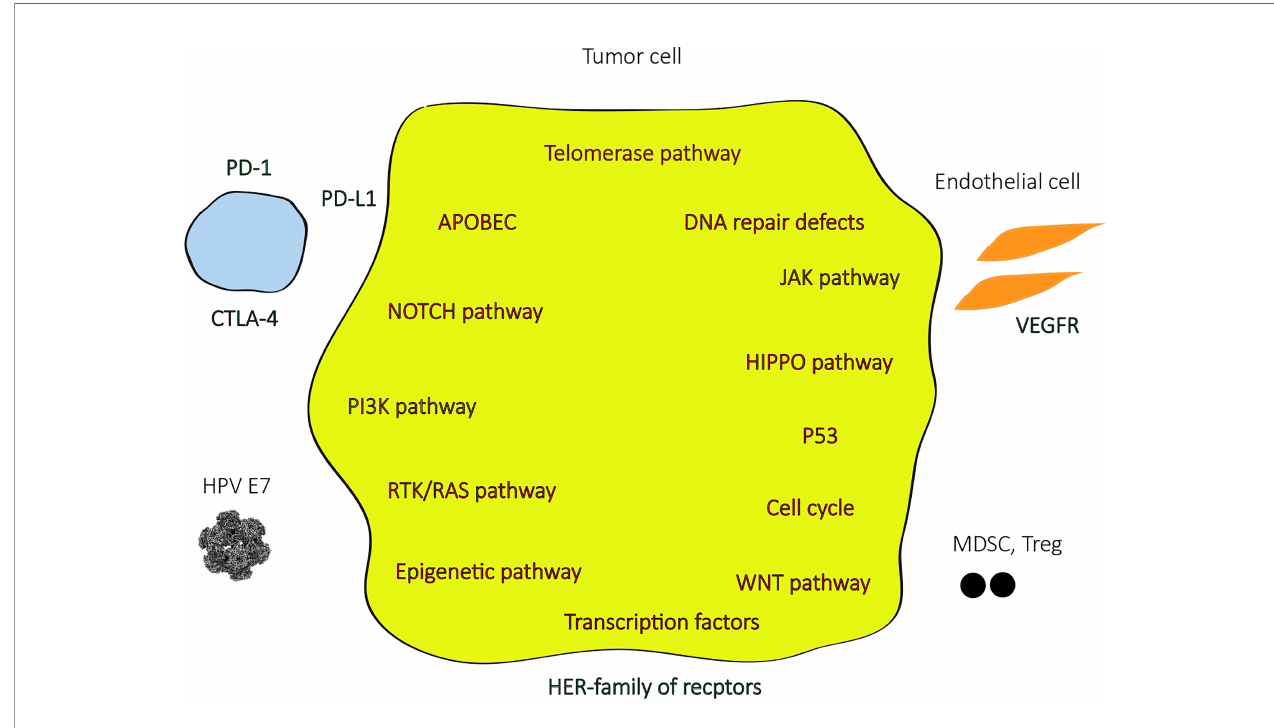
FIGURE 1 | Genomic alterations, mutation signatures, and tumor microenvironment on penile